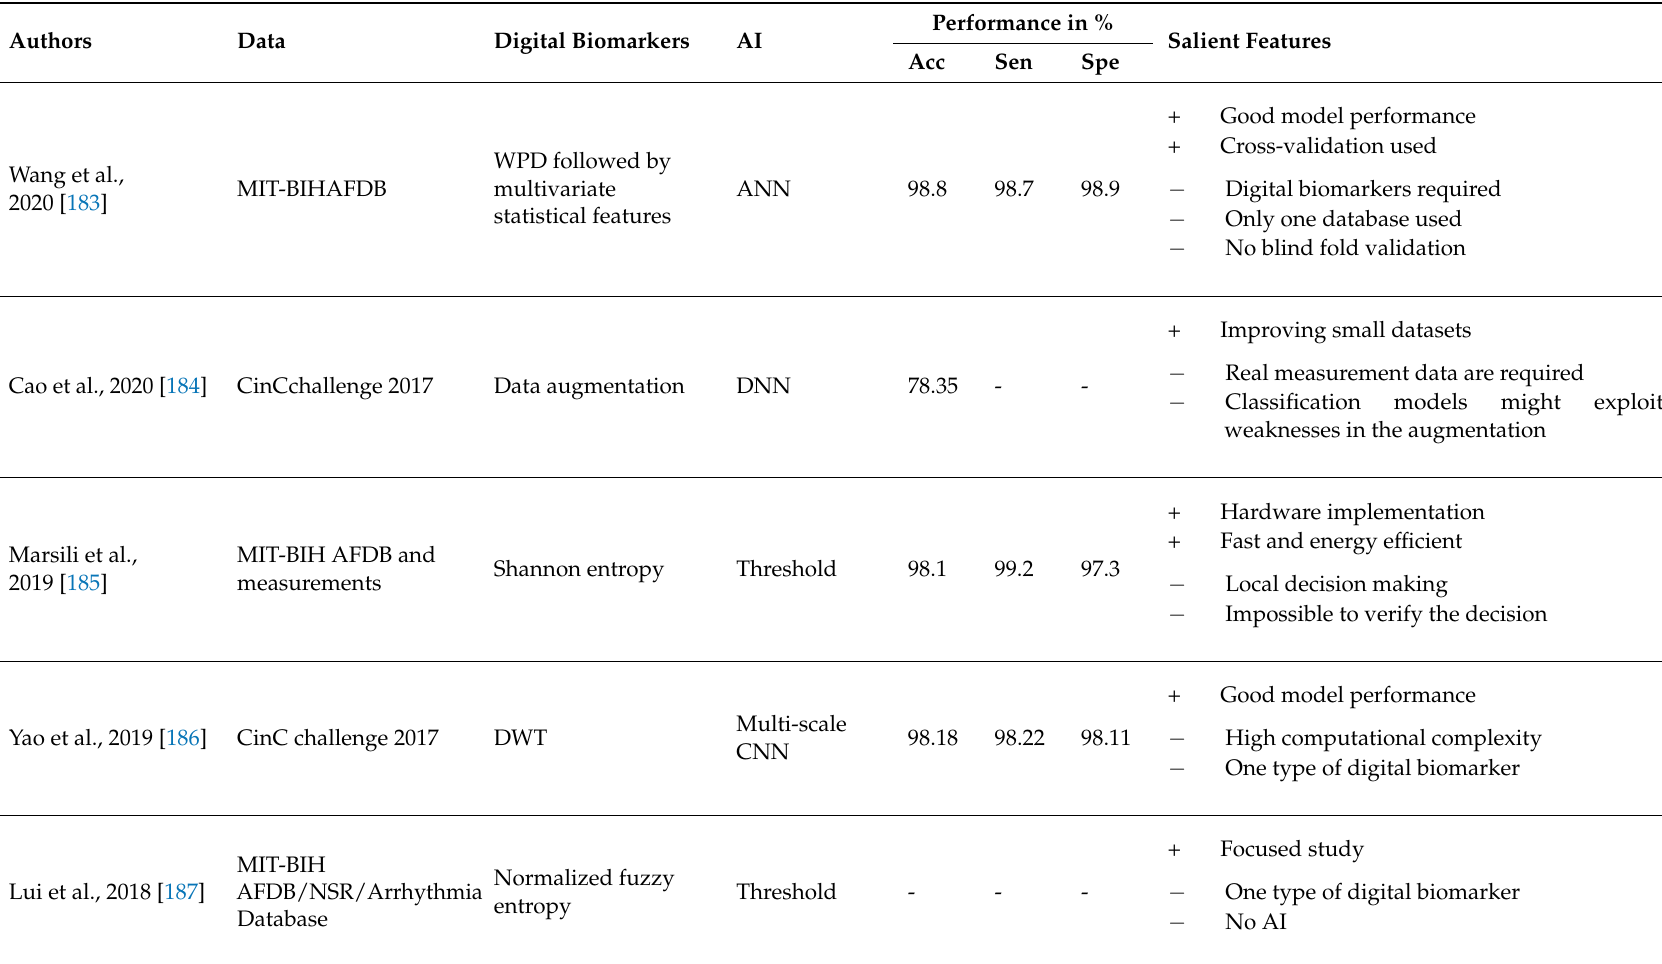
Table 1. A summary of automated AF detection in ECG signals. A “ + ” in the Salient features column indicates a positive point. Conversely, a “ − ” indicates a negative